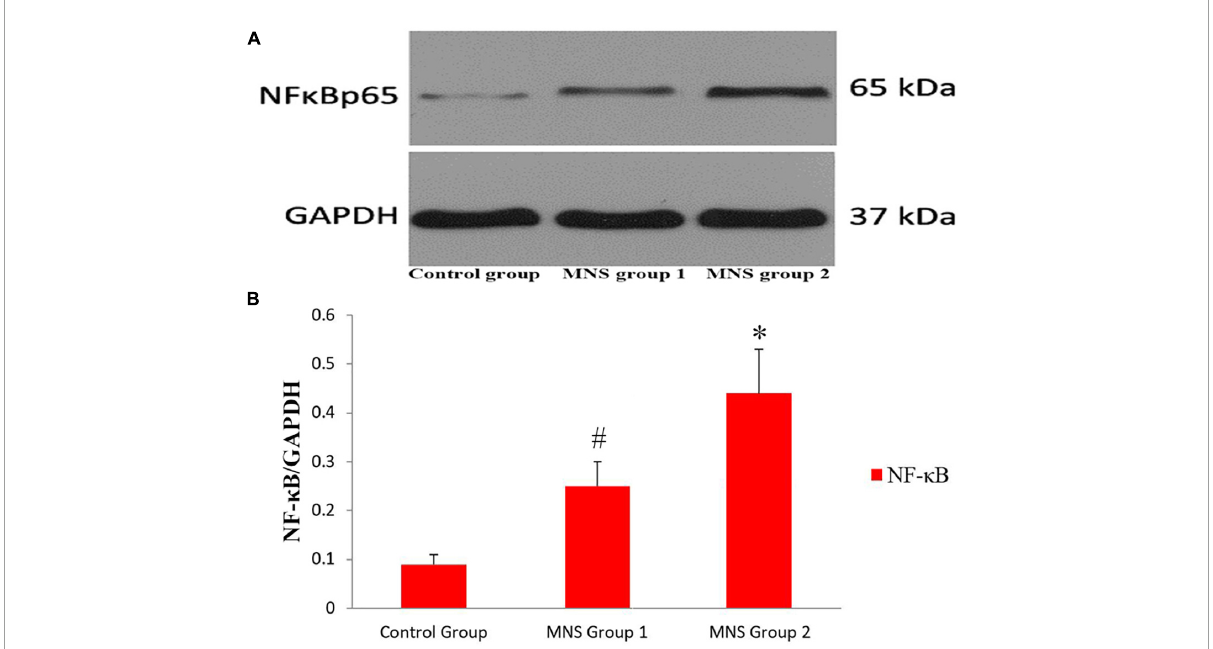
FIGURE6 Expression of nuclear transcription factor- κ B (NF- κ B) protein in the left ventricular tissues. (A,B) Representative examples and quantitative analyses of NF- κ B expression in the control, median nerve stimulation (MNS) group 1, and MNS group 2 dogs. # P < 0.01 vs. control group and MNS group 2; ∗ P < 0.01 vs. control